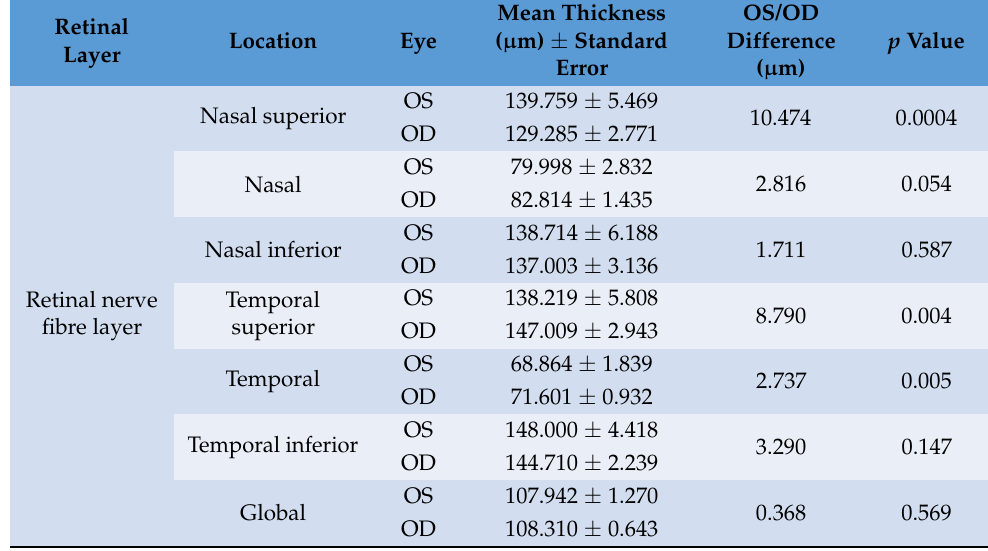
Table 5. Retinal layer thicknesses and inter-eye differences. OS: left eye; OD: right eye.